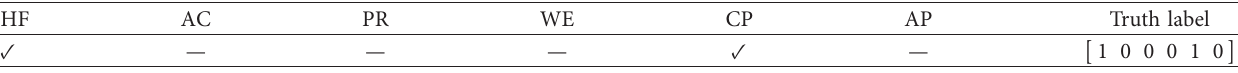
Table 10: An example of how multiple labels are prepared for each incident report using one-hot encoding. HF AC PR WE CP AP Truth label ✓ — — — ✓ — 1 0 0 0 1 0 􏼂 􏼃 1 indicates that a factor is present, and 0 indicates that a factor is absent. Matches and mismatches of multiple labels prepared in this way can be conveniently evaluated by the Python scikit-learn library